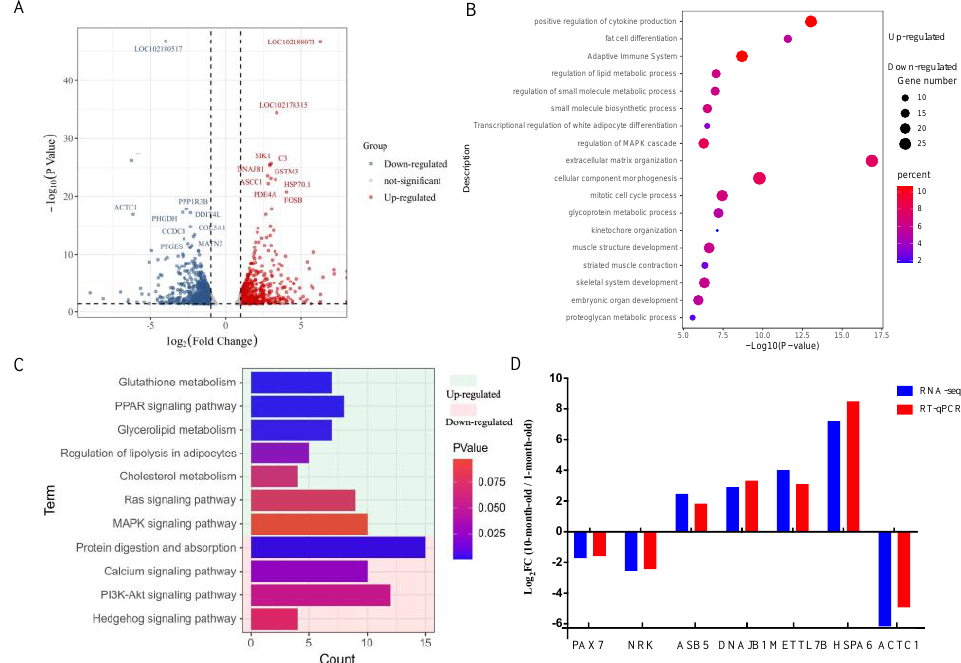
Figure 2. Differential expression analysis of mRNAs in longissimus dorsi between 1-month-old and 10-month-old Longlin goat. ( A ) Volcano plots of up-regulated and down-regulated DEGs of longissimus dorsi between 10-month-old and 1-month-old Longlin goat. The gray dots represent non-significantly DEGs, the 327 red dots represent significantly differentially up-regulated mRNAs, and the 419 blue dots represent significantly differentially down-regulated mRNAs. ( B ) GO analysis of DEGs of longissimus dorsi between 10-month-old and 1-month-old Longlin goat. Light green represents terms of up-regulated gene; Light red represents terms of down-regulated gene. ( C ) KEGG analysis of DEGs of longissimus dorsi between 10-month-old and 1-month-old Longlin goat. Light green represents terms of up-regulated genes; Light red represents terms of down-regulated genes. ( D ) RT-qPCR of DEGs compared with RNA-seq. Results of RT-qPCR analysis (Parallel analysis with RNA-seq results) of DEGs fold-change in longissimus dorsi between 10-month-old and 1-month-old Longlin goat. The relative expression of each mRNA was calculated using the 2 − ∆∆ ct method. The data are presented as mean ± SEM from three independent